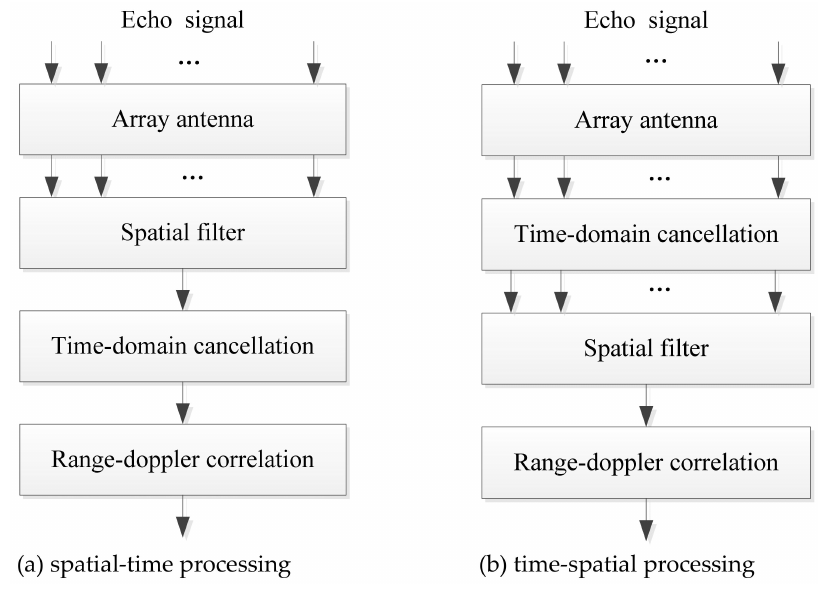
Figure 2. Flow charts of the ( a ) spatial-time and ( b ) time-spatial